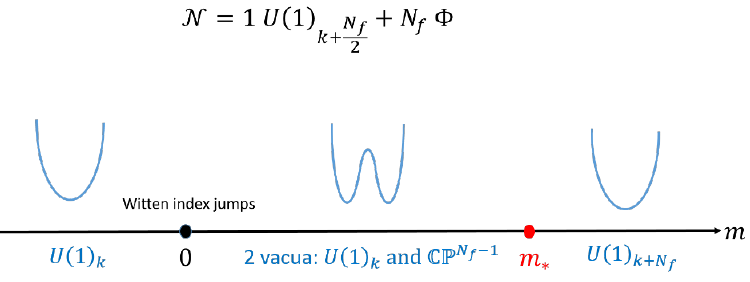
gauge theory coupled to N f charge 1 matter